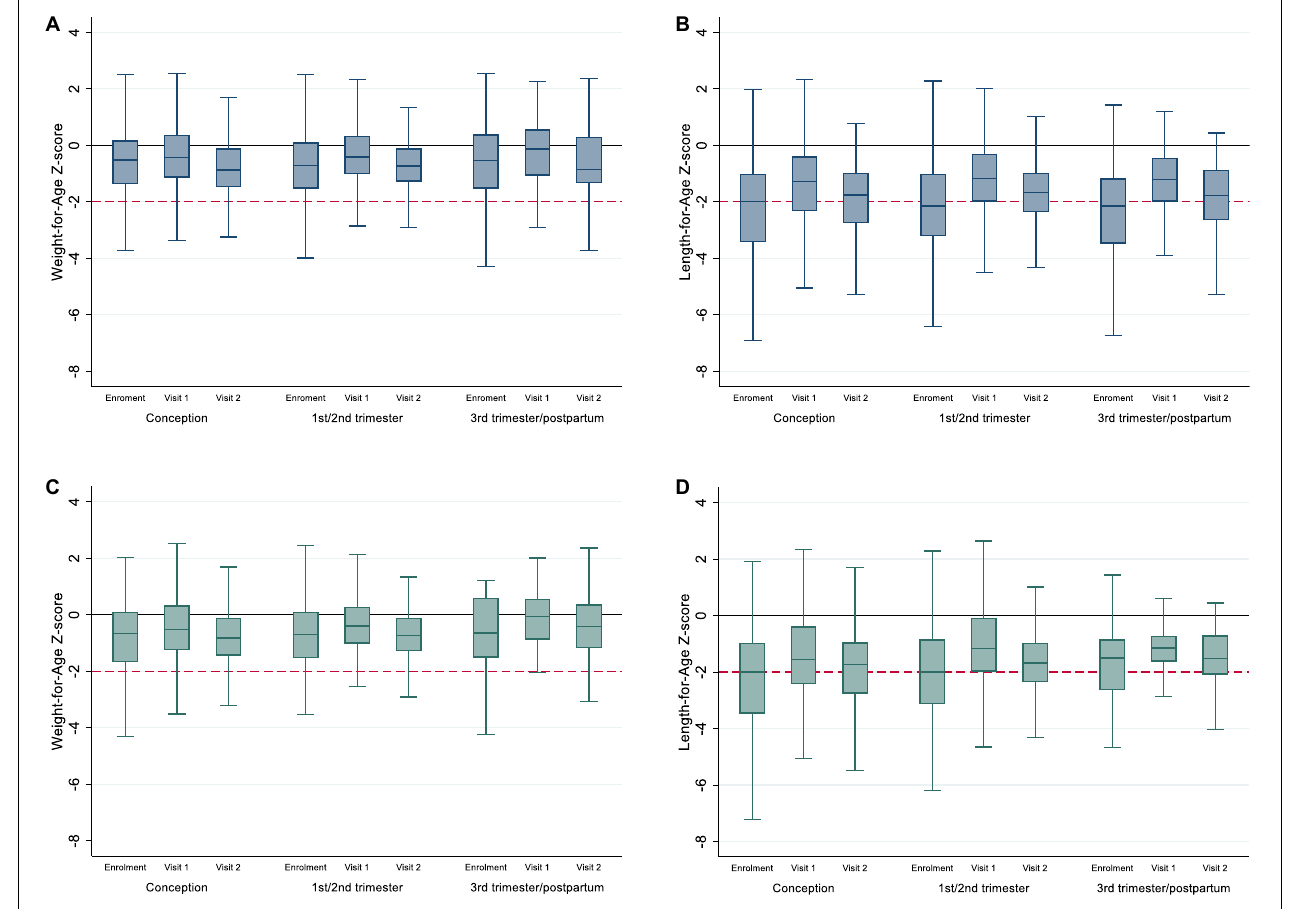
FIGURE 2 | (A,B) Weight-for-Age and Length-for-Age Z-scores for whole cohort of CHEU by timing of ART exposure and study visit; (C,D) Weight-for-Age and Length-for-Age Z-scores for complete cases by timing of ART exposure and study visit. Y-line at 0 represents median WAZ and LAZ for the reference population, and y-line at -2 represents underweight (A,C) and stunting (B,D) . Outliers have been excluded from the box